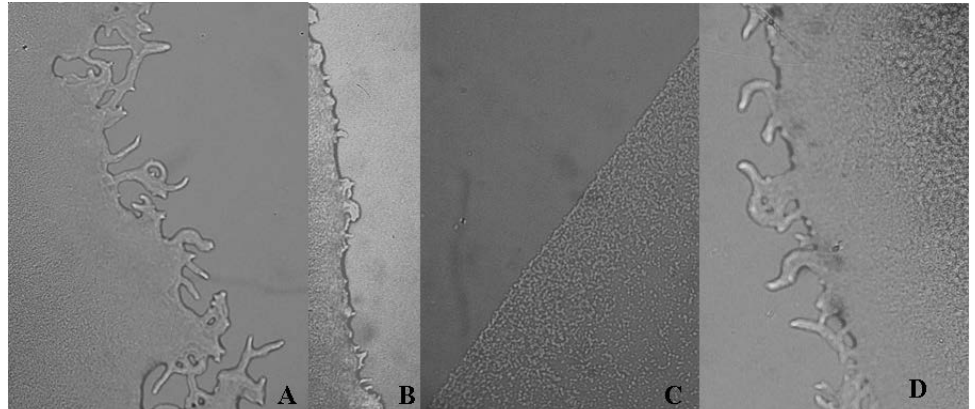
Figure 2. Flagella motility of Pseudomonas aeruginosa treated with Agaricus blazei extract.